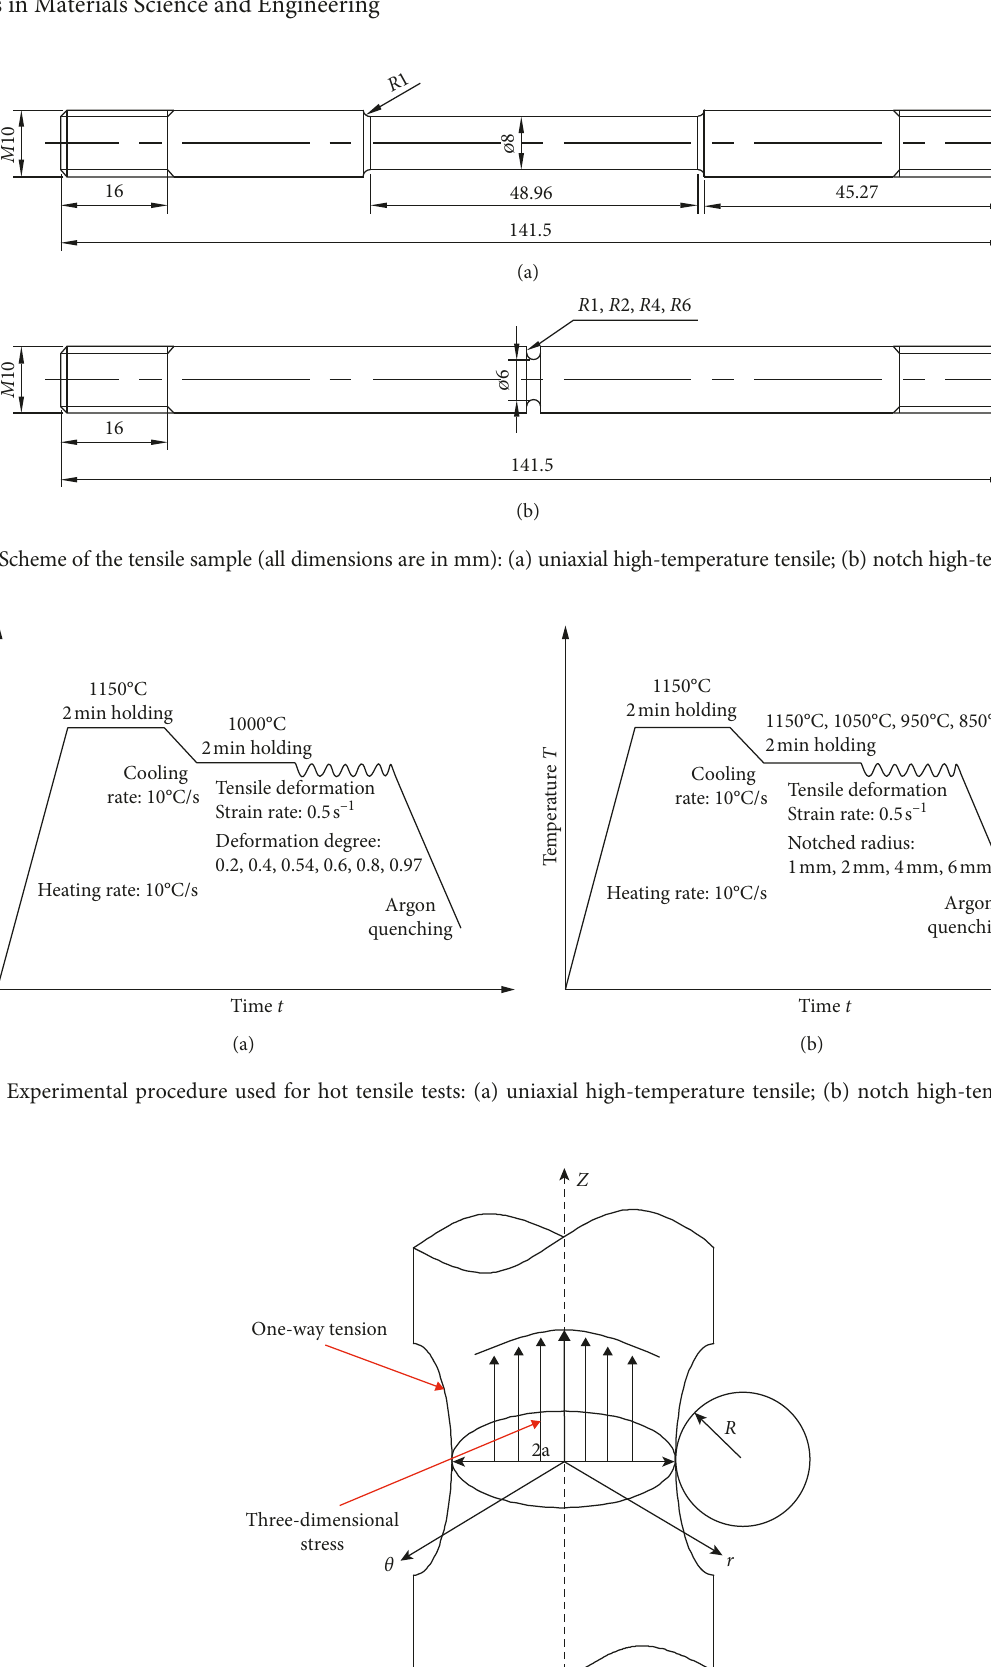
Three-dimensional